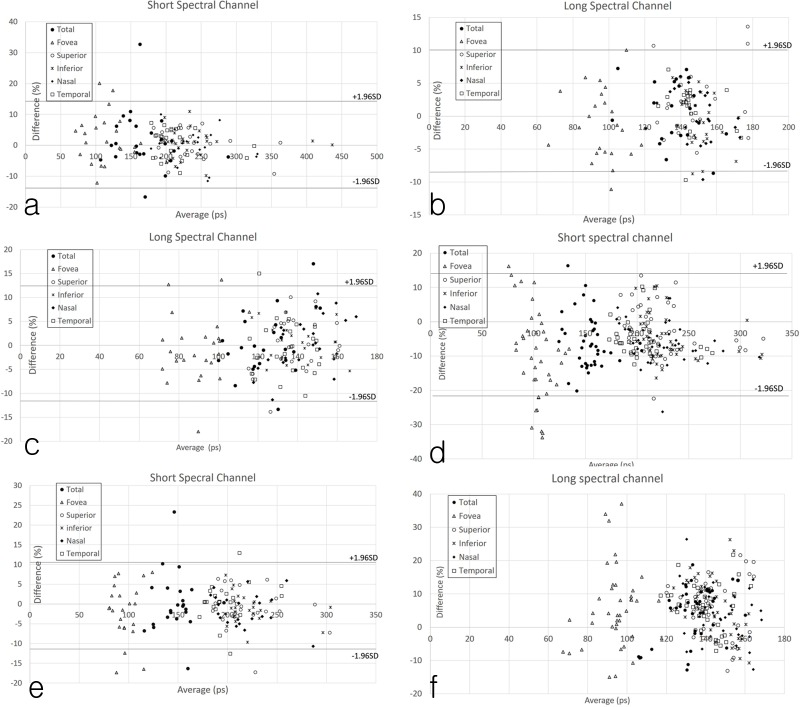
Bland-Altmans plot for repeatability of the 1st and 2nd measurements from the short spectral channel (SSC) and long spectral channel (LSC).SSC (a) and LSC (b) in the dilated setting, and SSC (c) and LSC (d) in the non-dilated setting. Bland-Altman plots comparing the measurements obtained in dilated and non-dilated setting for the SSC (e) and LSC (f) from both 1st and 2nd measurements. Individual points represent values for the total scan area as well as within specific macular regions.